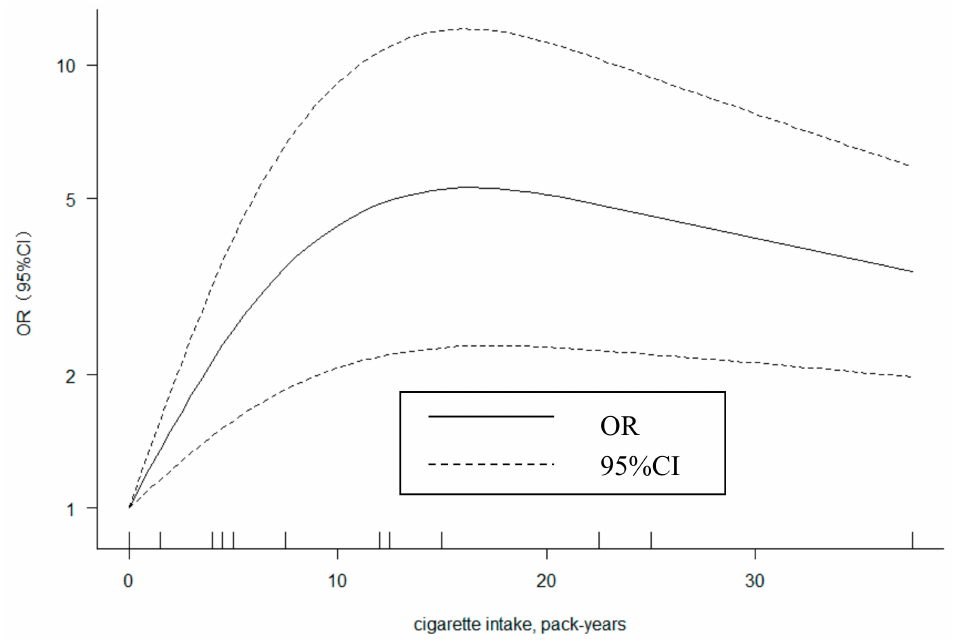
Figure 3. Dose-response relationships for cigarette intake pack-years and